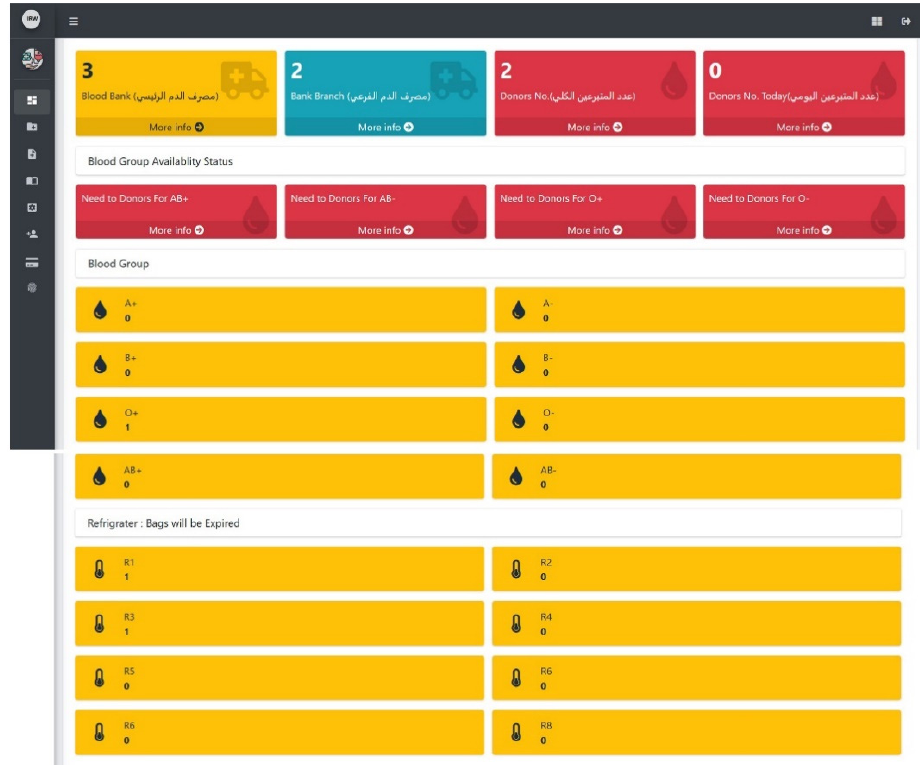
Figure 7. The main dashboard .